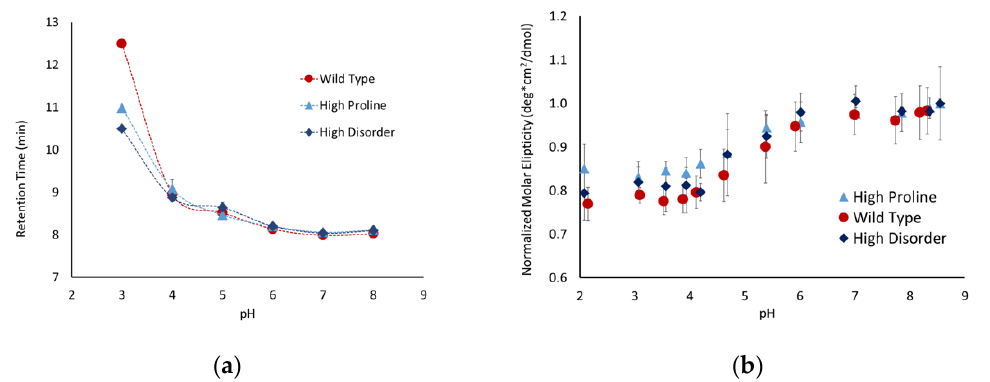
Figure 6. pH-dependent conformational changes as observed with ( a ) size-exclusion chromatography and ( b ) circular dichroism. Circular dichroism values at 200 nm were taken and normalized to the highest pH point for the peptide.